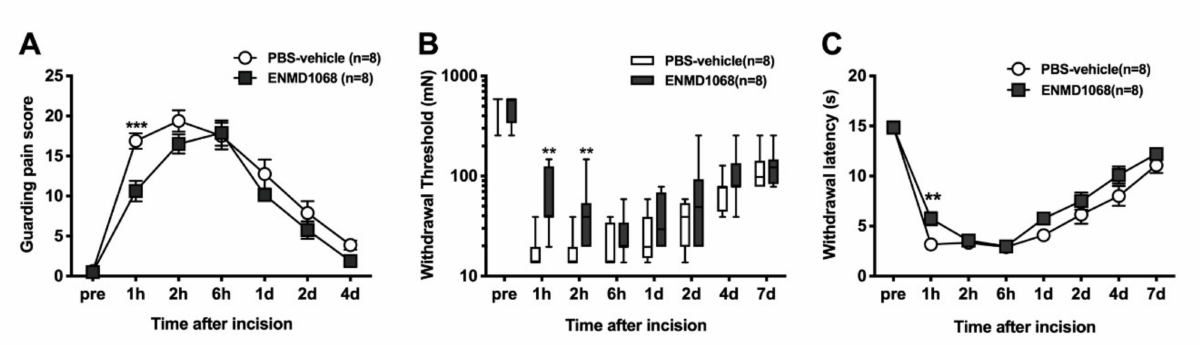
Figure 2. Effects of PAR-2 antagonist N3-methylbutyryl-N-6-aminohexanoyl-piperazine (ENMD 1068) on pain behaviors of rats after incision. ( A ) Guarding pain behavior. The results are presented as the mean and SEM for eight rats in each group ( n = 8 to both groups). Statistical analysis used 2-way ANOVA with repeated measures on one factor followed by Bonferroni’s post hoc t-test for comparing the mean cumulative pain score at each time point between groups. ( B ) Withdrawal threshold to mechanical stimuli applied to the hind paw. The results are presented as the median with interquartile range (box) and 10th and 90th percentile for eight rats in each group ( n = 8 to both groups). A non-parametric Friedman’s test followed by Dunn’s post hoc test for between- group comparisons at each time point were used. ( C ) Withdrawal latency to heat stimuli. The results are presented as the mean and SEM. Statistical analysis used 2-way ANOVA with repeated measures on one factor followed by Bonferroni’s post hoc test for comparing the mean withdrawal latency at each time point between groups ( n = 8 to both groups). ** p < 0.01, *** p < 0.001 compared with the vehicle group at each time point. POD = postoperative